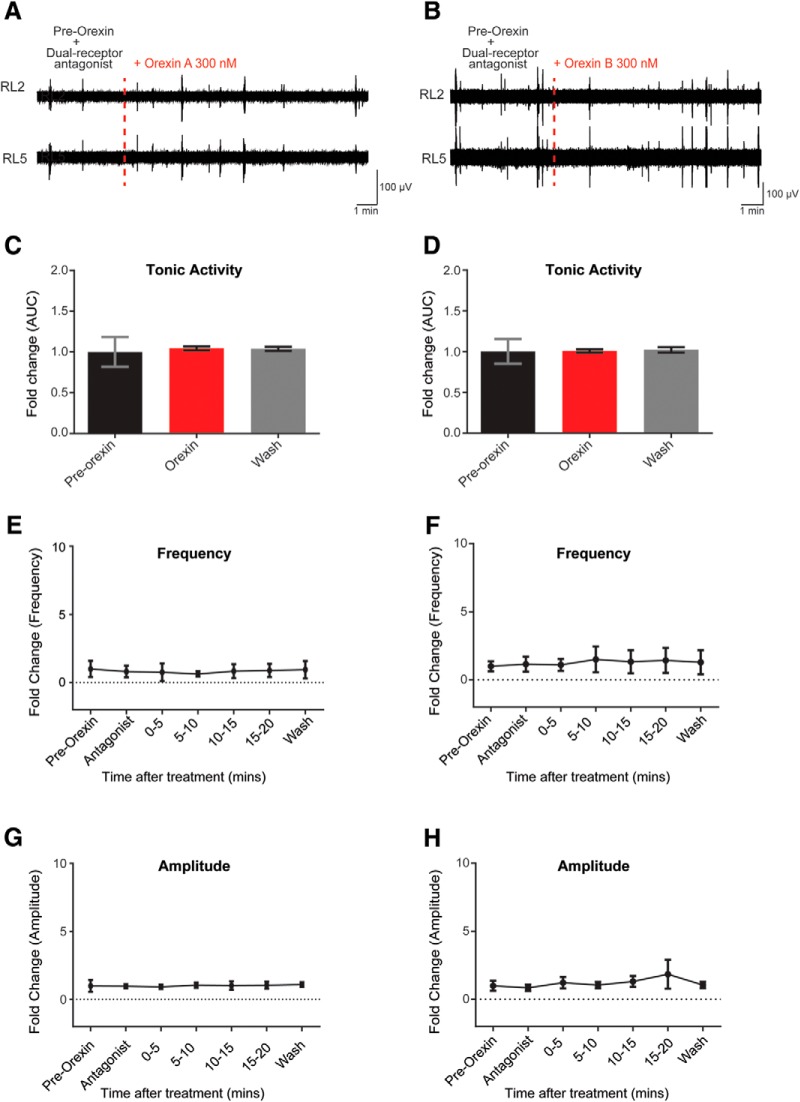
OXR antagonist abolished OXA or OXB-mediated excitation. A, B, Representative neurogram of recorded motor spontaneous activity when the OX1R and OX2R (dual receptor) antagonist TCS 1102 (10 μm) was applied to the isolated spinal cord preparation before the addition of 300 nm OXA (A) or OXB (B; indicated at the red dotted lines), respectively. Pre-OX + antagonist indicates period when antagonist was added to the aCSF. C, D, Bar graphs representing the fold change of the tonic activity: pre-OX + antagonist (black); OXA (C; 300 nm; red); OXB (D; 300 nm); washout (gray) of OXA (C) or OXB (D) in the presence of dual antagonist. E, F, Graphs representing the evolution of the fold change in frequency of the spontaneous activity comparing pre-OX, OXA (E), or OXB (F) observed at different times following the application of OXA or OXB in the presence of TCS 1102. G, H, The fold change in amplitude of the spontaneous bursts during OXA or OXB bath application, in the presence of TCS 1102. N = 4 for the dual receptor antagonist experiments, respectively. Data are represented as the mean ± SD.